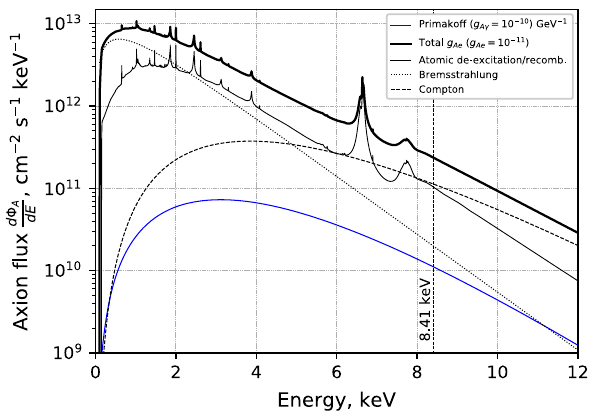
Fig. 1 The calculated energy spectra of solar axions produced due to the axion–photon [25] and axion–electron couplings [30]. The spectra are calculated in assumption of massless axion ( m A = 0) for nominal g A γ and g Ae values relevant to the range of experimental